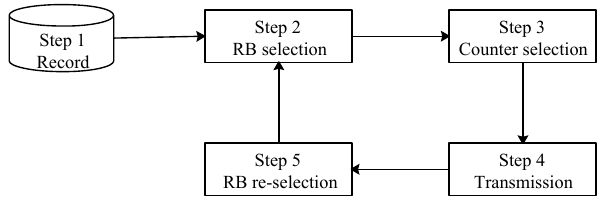
Figure 8. Workflow of